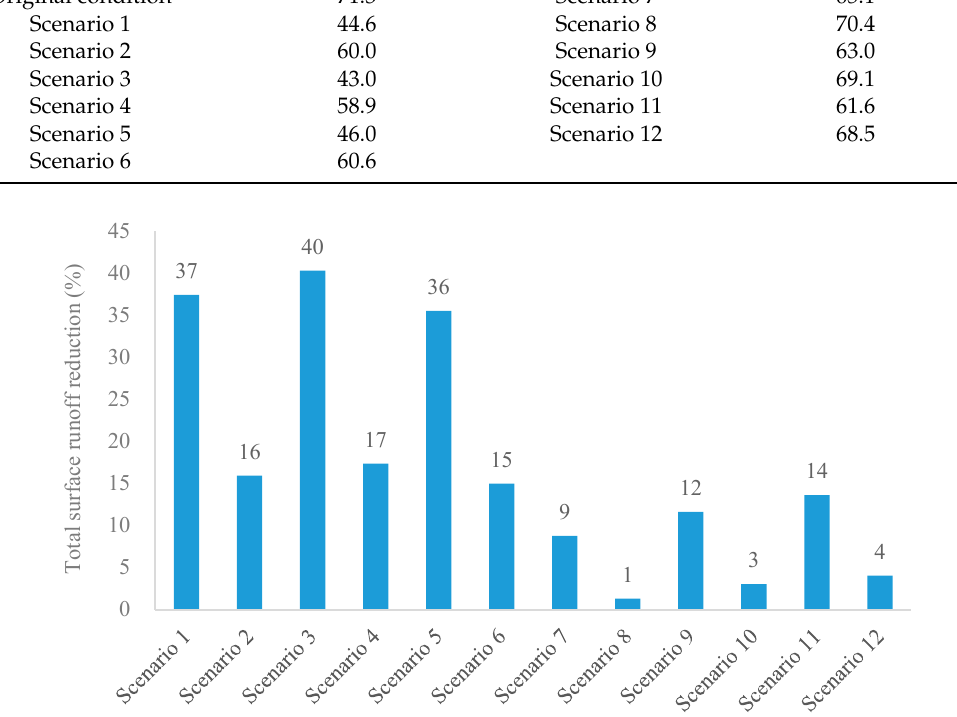
Figure 3. Percent of total surface runoff reduction by implementation of different permeable pavements.